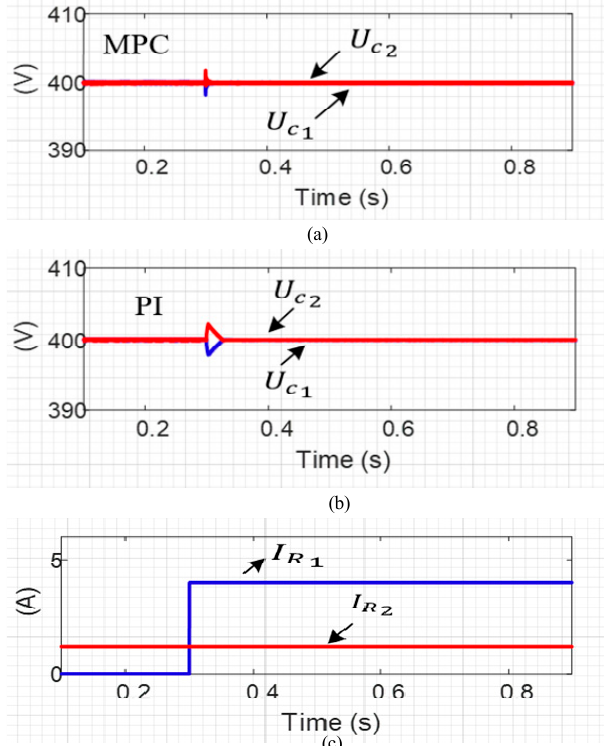
Figure 19. Experimental results. ( a ) Transient load response with MPC. ( b ) Transient load response with PI. ( c ) When load I R 1 is increasing.